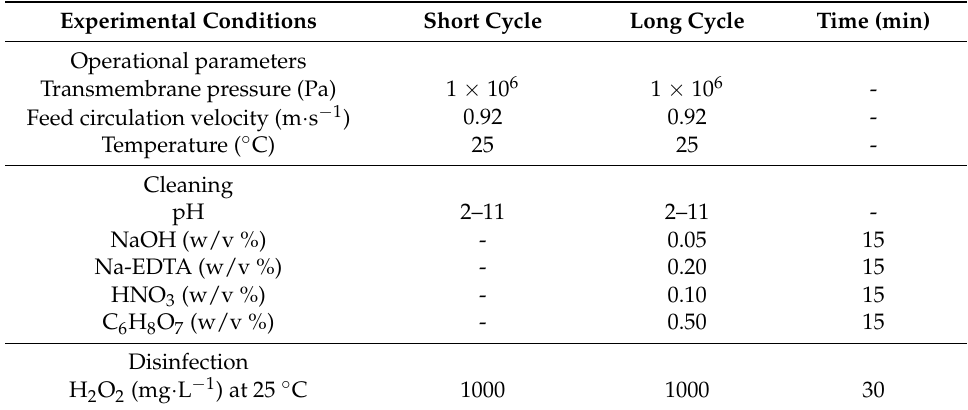
Table 1. Process of cleaning and disinfection of nanofiltration membranes a .